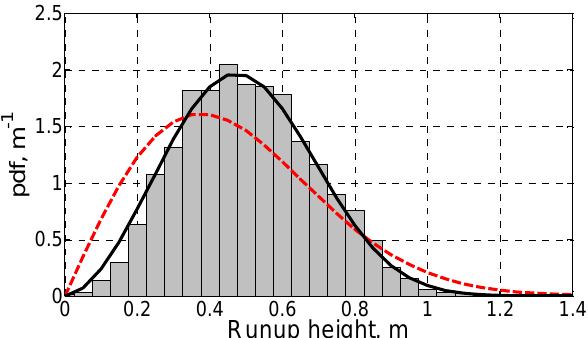
Fig. 6. Averaged distribution of run-up heights within the wave wake; red dashed line corresponds to the Rayleigh distribution ( σ = 0 . 38m), black solid line corresponds to the Weibull distribution ( σ = 0 . 56m, q = 2 . 77) fitted using the maximum likelihood estimate.